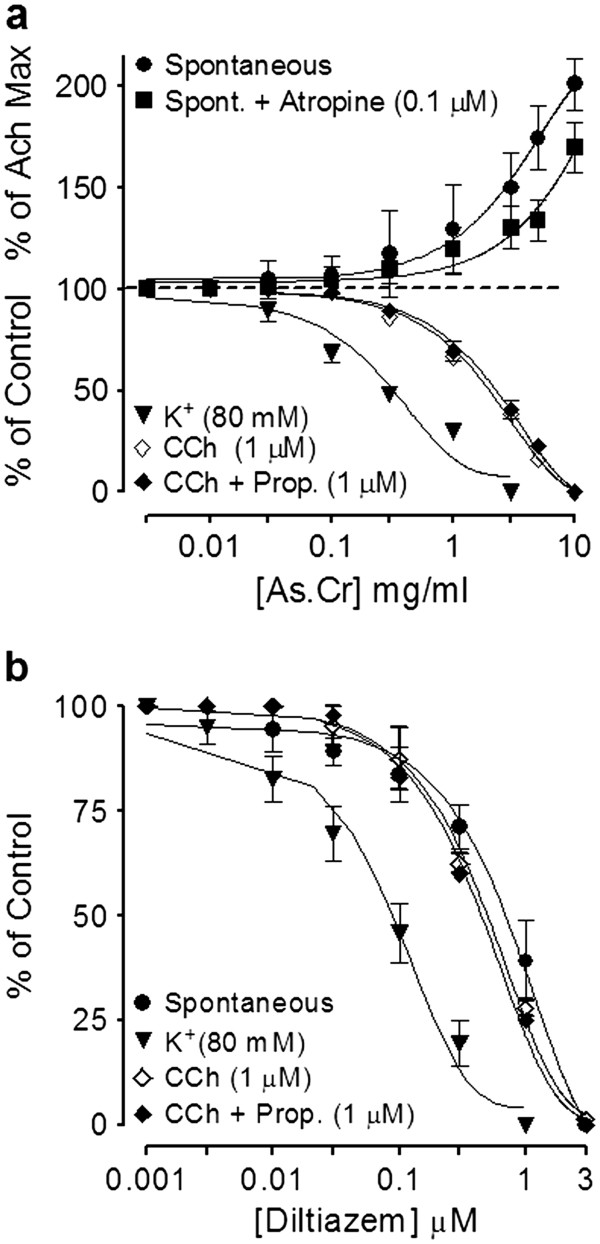
Concentration-dependent effect of (a)the crude extract ofA. spinosus(As.Cr) and (b) diltiazemon spontaneous, K+and carbachol (CCh)-induced contractionsin isolated rabbit jejunum. The stimulant effect of As.Cr on spontaneous contraction is taken in the absence and presence of atropine (0.1 μM), while the inhibitory effect of both As.Cr and diltiazem against CCh-induced contractions is taken in the absence and presence of propranolol (Prop., 1 μM). Values shown are mean ± S.E.M., n = 3–5.